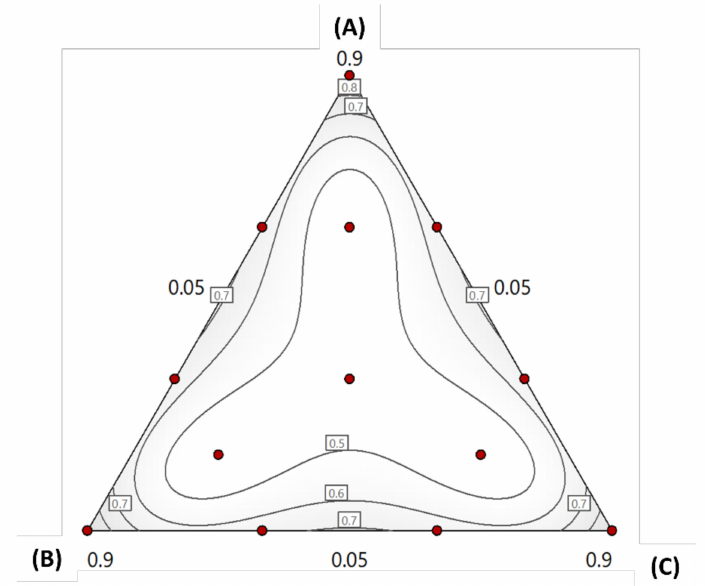
Figure 1. Simplex lattice design used for optimization of Fr-SNEDS (oil ( A ), surfactant ( B ), and cosurfactant ( C